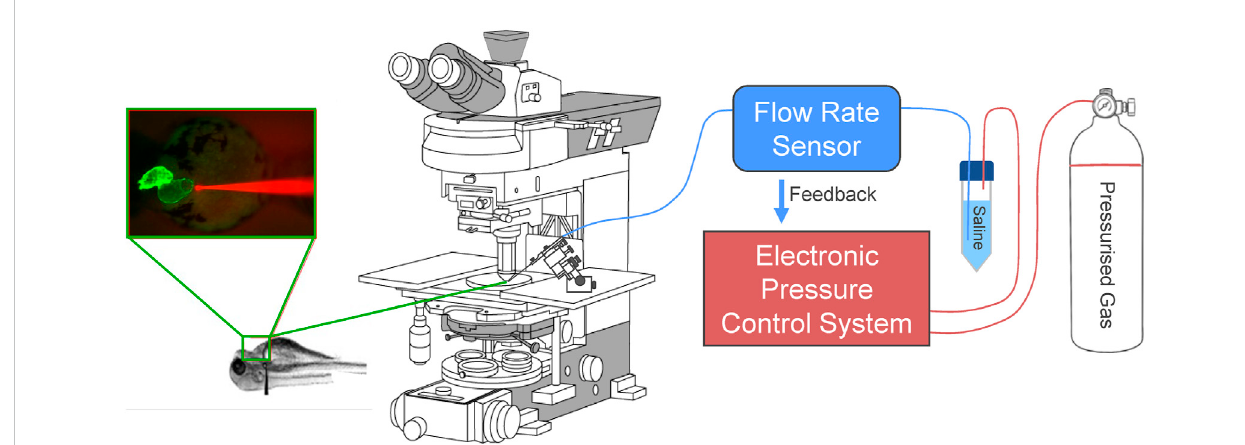
FIGURE 1 Electronic fl ow control system for acutely increasing cardiac preload in intact larval zebra fi sh. Outlet pressure of a pressurised gas cylinder is modulated by a computer-controlled high-resolution electronic pressure control system, which pressurises a conical tube fi lled with saline solution. Flowratefromthetubeismeasuredbyabidirectional fl owratesensorandmaintainedatasetvaluebyadjusting pressure.Amicro-cannula isconnected to the fl ow outlet, advanced with a micromanipulator under an upright fl uorescence microscope to puncture the common cardinal vein